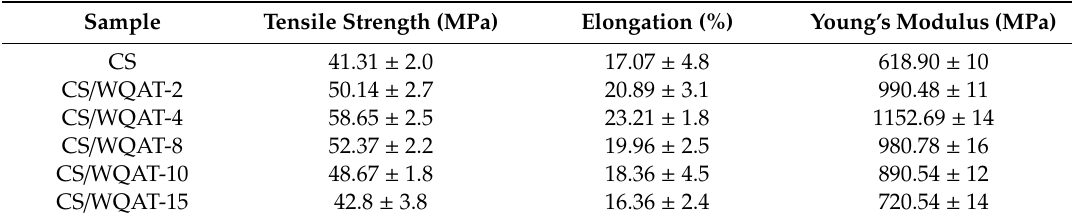
Table 1. Mechanical properties of the pure CS and CS/WQAT composite membranes.